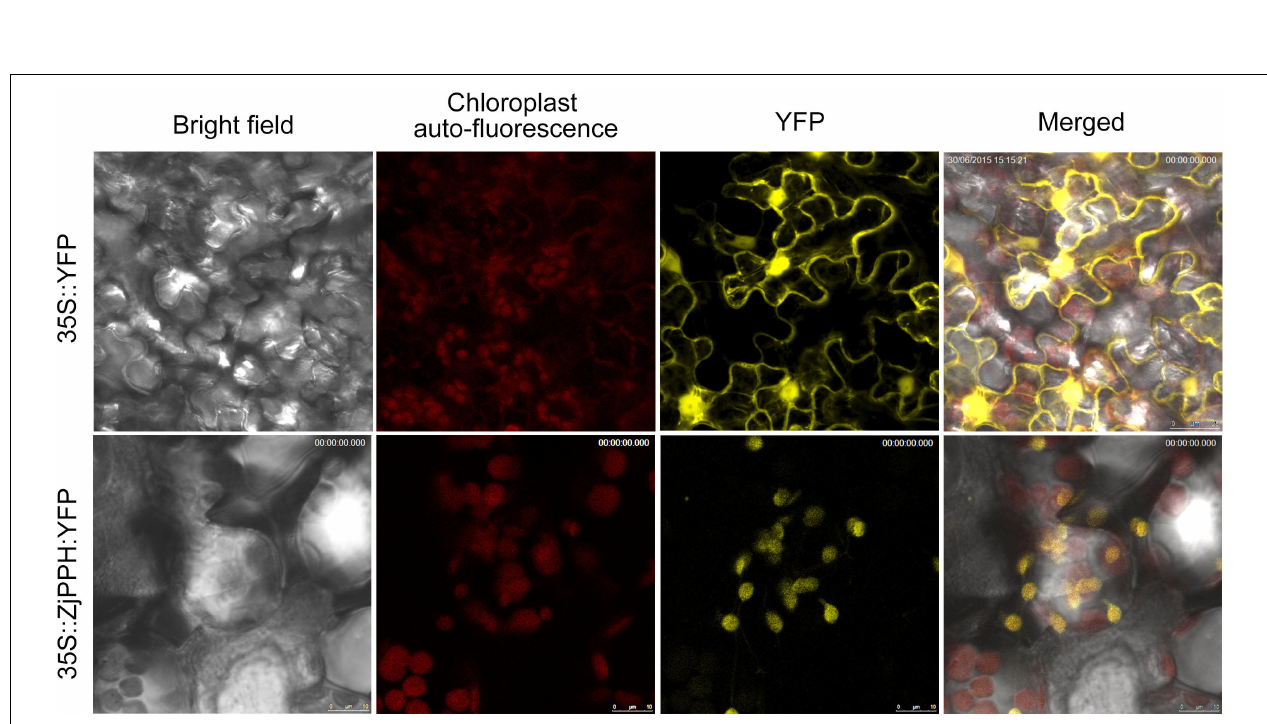
FIGURE 4 | Subcellular localization of